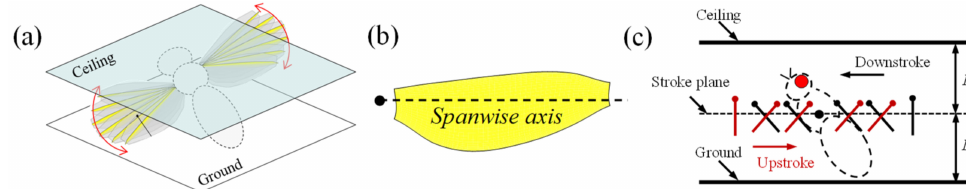
Figure 1. ( a ) Schematic motion of the wing between the ceiling and the ground, a wing model is shown as an insect; ( b ) wing’s planform shape; and ( c ) side view of a wing section’s motion. The black dot indicates the wing base, and D c and D g mean the ceiling clearance and the ground clearance, respectively. In this paper, D c = D g = D . The position of the section on the wing is shown in ( a